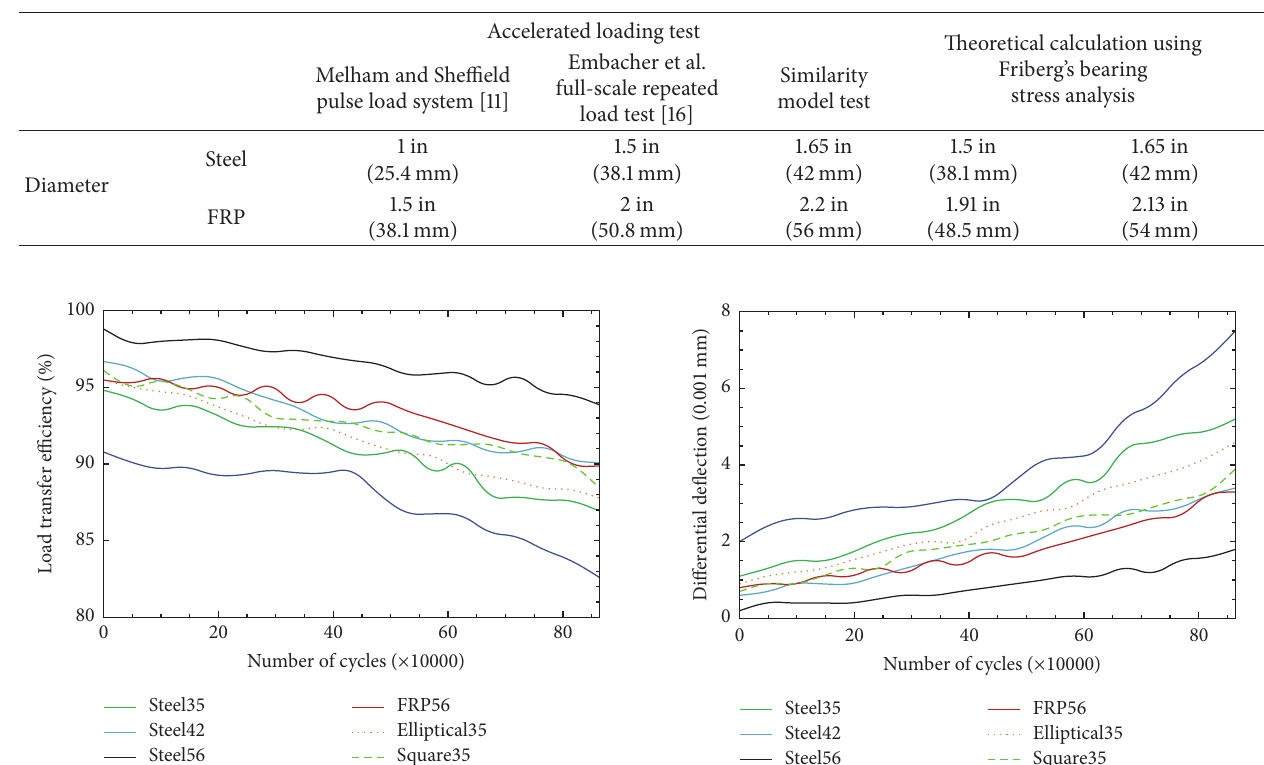
Table 6: Steel dowel and FRP dowel having the same performance.